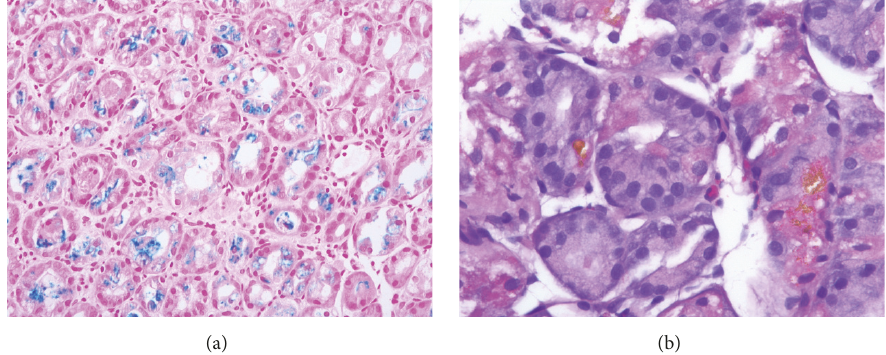
Figure 3: (a) An iron stain with intraepithelial and intraluminal iron (blue stain). Prussian blue, 200x. (b) A high-power view of the stomach shows parietal and chief cells containing intracytoplasmic yellow-orange coarse granules consistent with iron deposition. H&E,